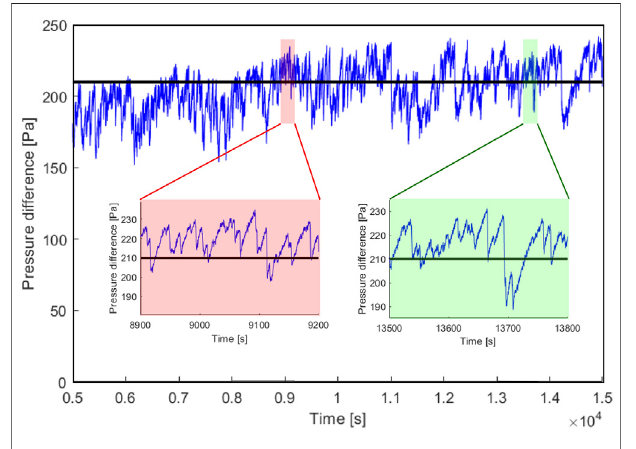
FIGURE 8 | Typical evolution of the pressure signal during an experiment. In this speci fi c case, the liquid was withdrawn from the bottom at a rate of 1 ml / h and the model was positioned horizontally, i.e., θ (cid:1) 0 ° . The thickhorizontal linedenotes acharacteristicaveragepressureduring the bursts 〈 p 〉 (cid:1) 210 Pa . The left and right insets (shaded respectively in red and green) show zoomed in sections of the signal, where we can see the characteristicHaines jumps.Thesignal looksstatisticallysimilarinboth insets, thus justifying the assumptions made in Eq. 24 .